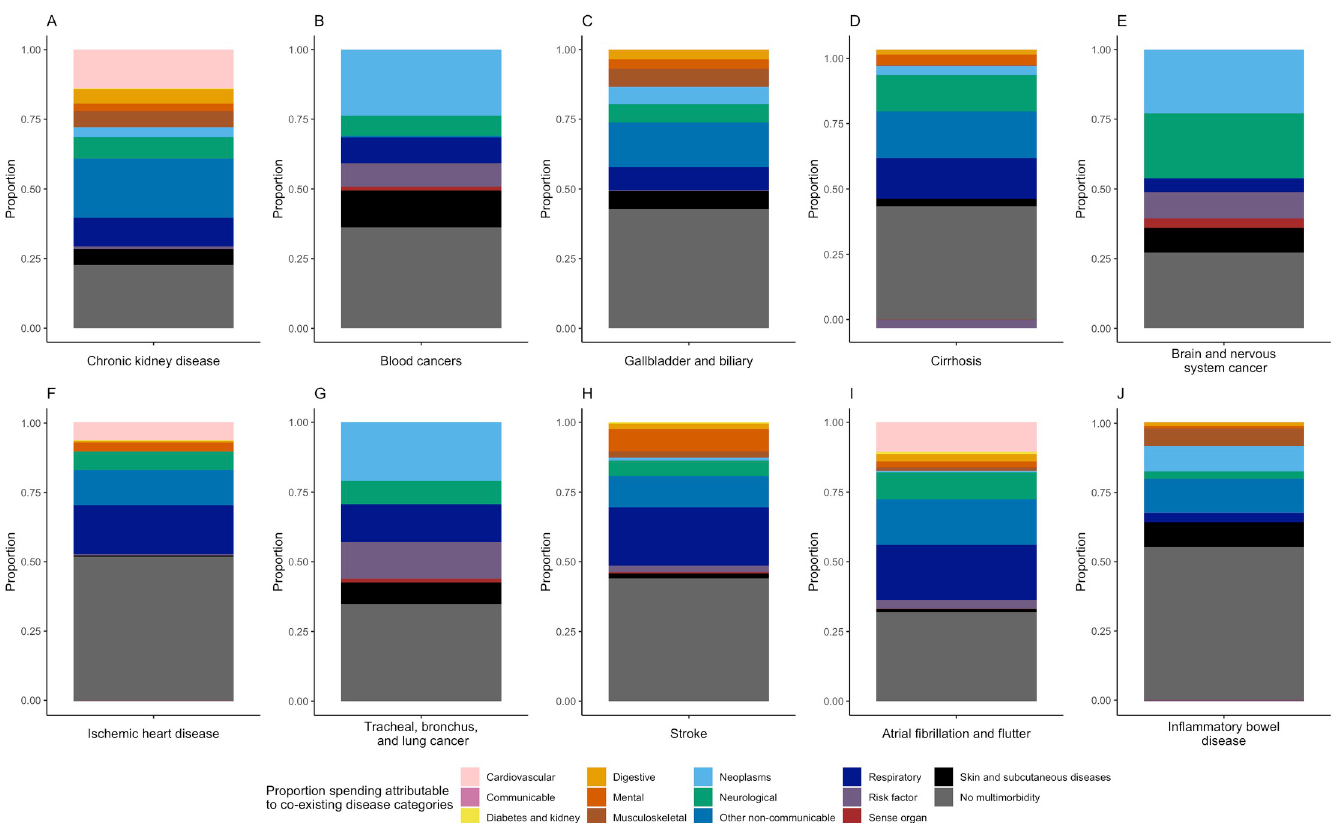
Fig 3. Decomposition of multimorbidity-adjusted spending by multimorbidity disease categories, for chronic conditions with the top 10 highest spending per treated case.